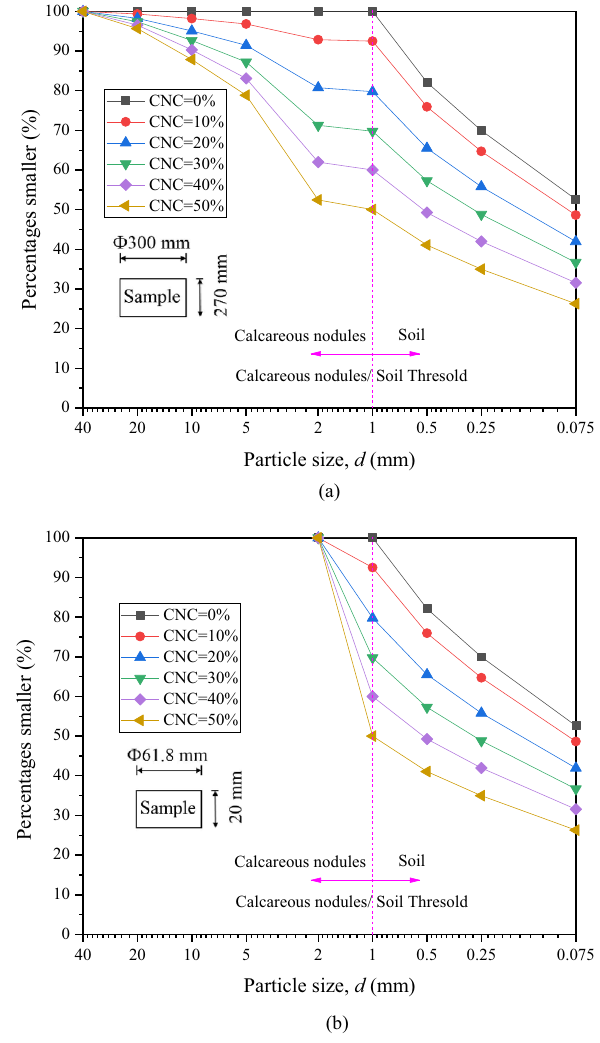
Figure 4. Gradation distributions of CSCN samples with ( a ) large size and ( b ) scaling